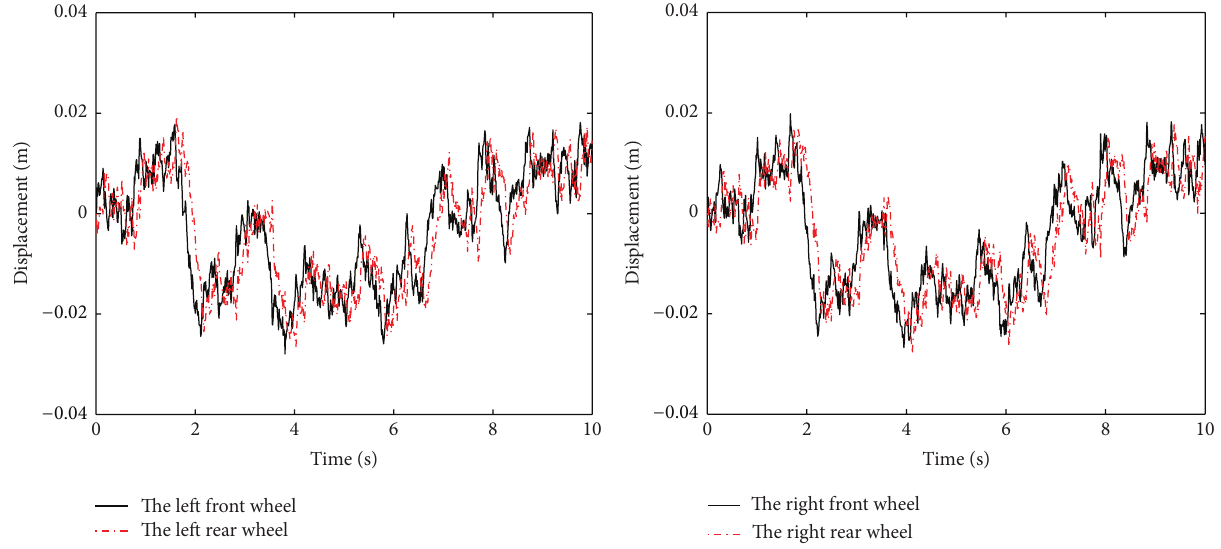
Figure 6: Road random input of four wheels.